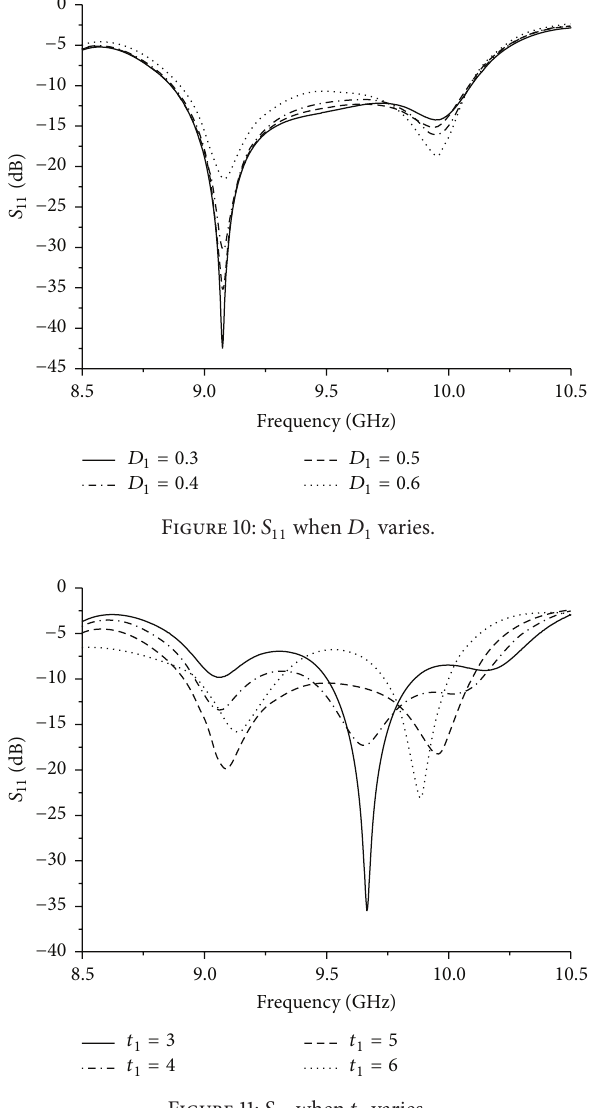
Figure 11: 𝑆 11 when 𝑡 1